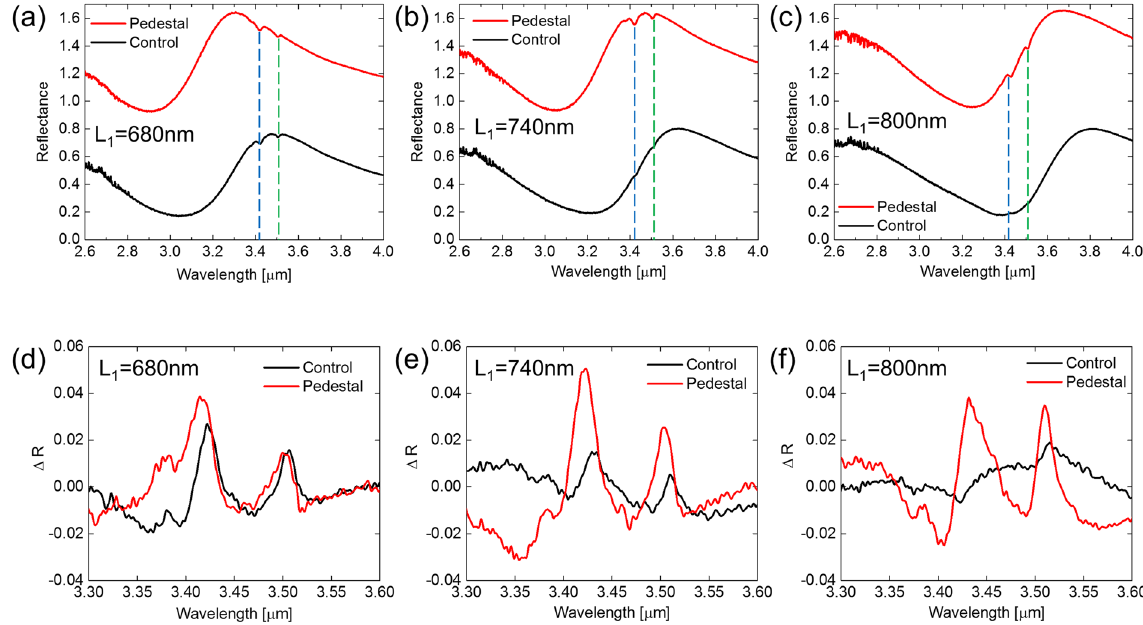
Figure 4. ( a – c ) Experimental reflection spectrum of the monolayer ODT-coated control FMM (black) and FMM on the nanopedestal (red) structures with three different nanoantenna lengths, L 1 , (( a ) L 1 = 680 nm, ( b ) L 1 = 740 nm, and ( c ) L 1 = 800 nm). The reflection spectra of the FMM on the nanopedestal structure have been given an offset of 0.8 for clarity. ( d – f ) Experimental reflection difference spectra of the two structures with ( d )